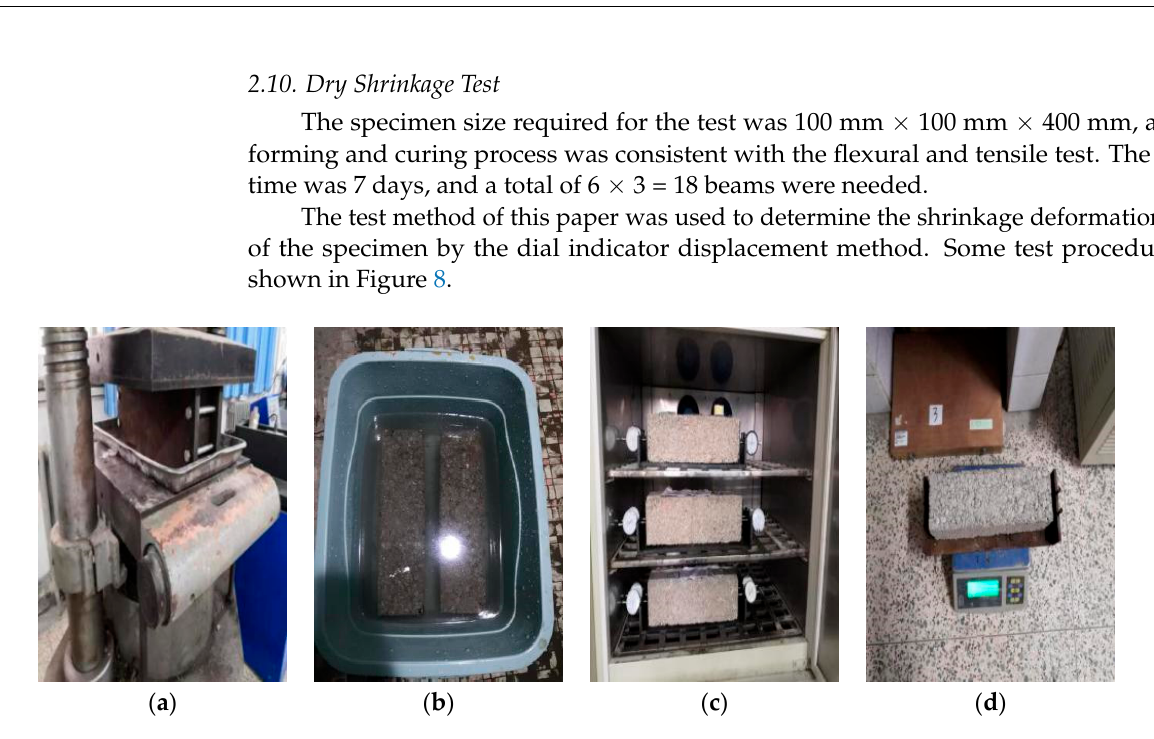
Figure 8. Specimen-making and observation of dry shrinkage test: ( a ) Forming; ( b ) Immersion; ( c ) Dry shrinkage measurement; ( d ) Water loss measurement.